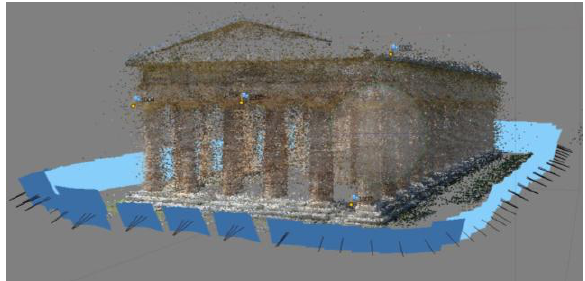
Figure 7. The point cloud in the model of the Temple of Neptune